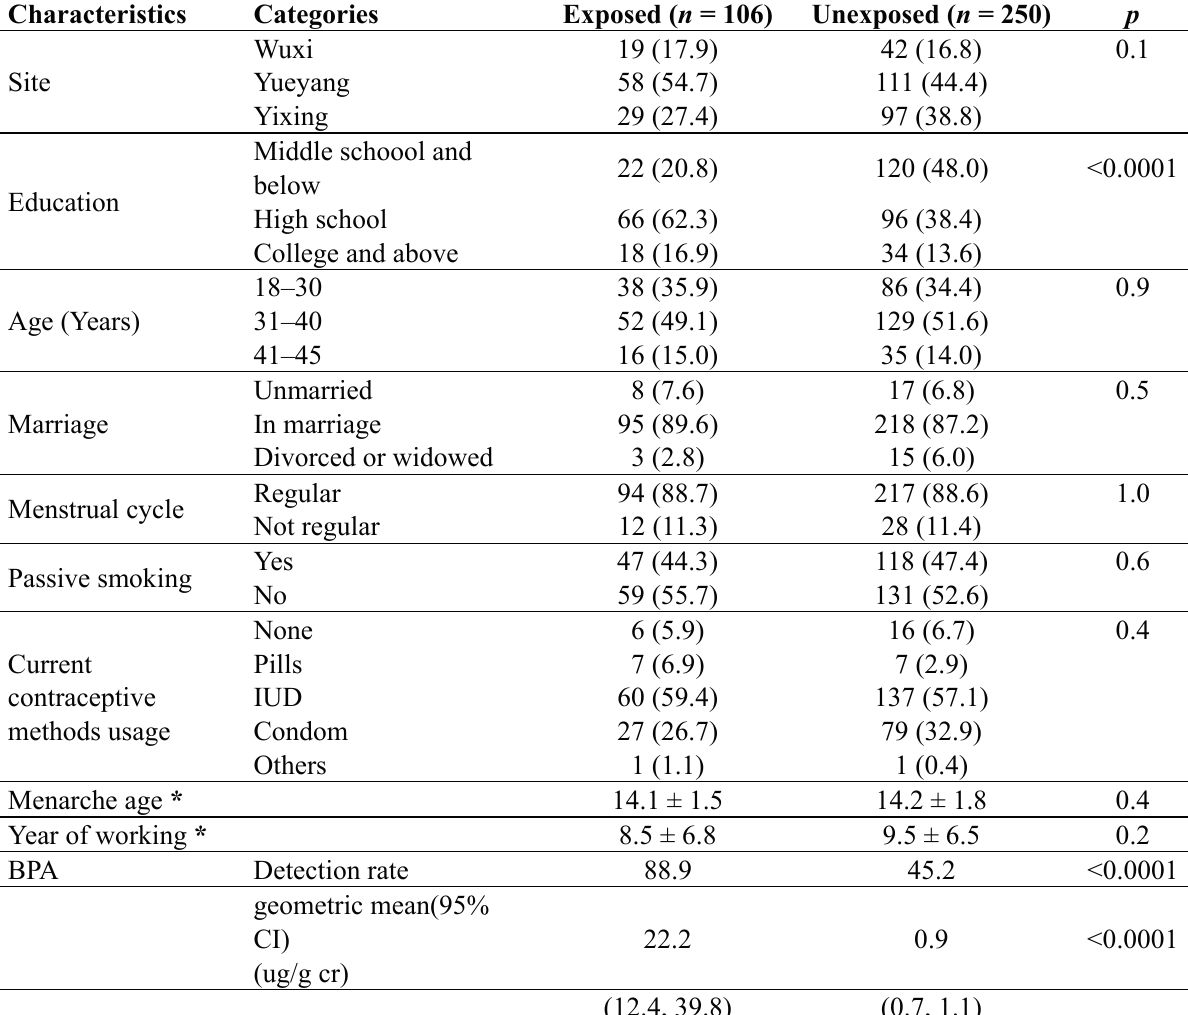
Table 1. Characteristic of women in exposed and unexposed